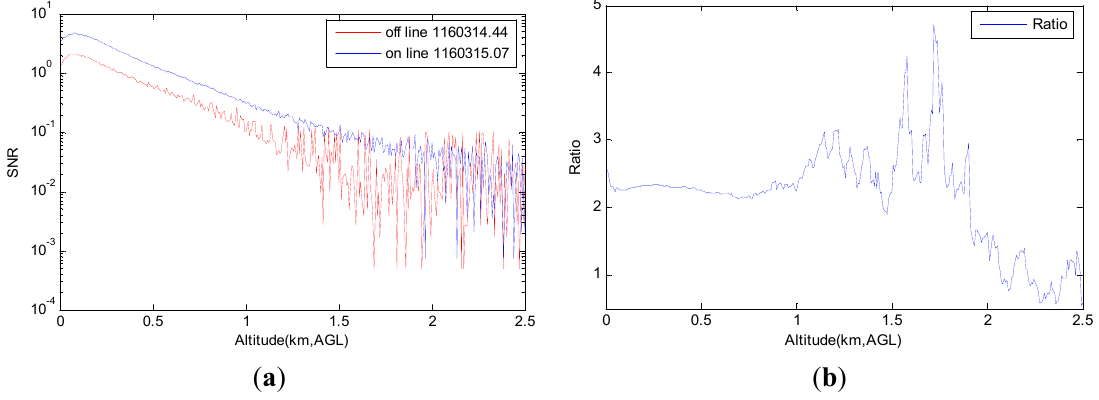
Figure 8. ( a ) The SNR of on-line and off-line measurements at night; ( b ) The SNR difference between on-line and off-line measurements at 12:00 UTC (night, 20:00 LST)